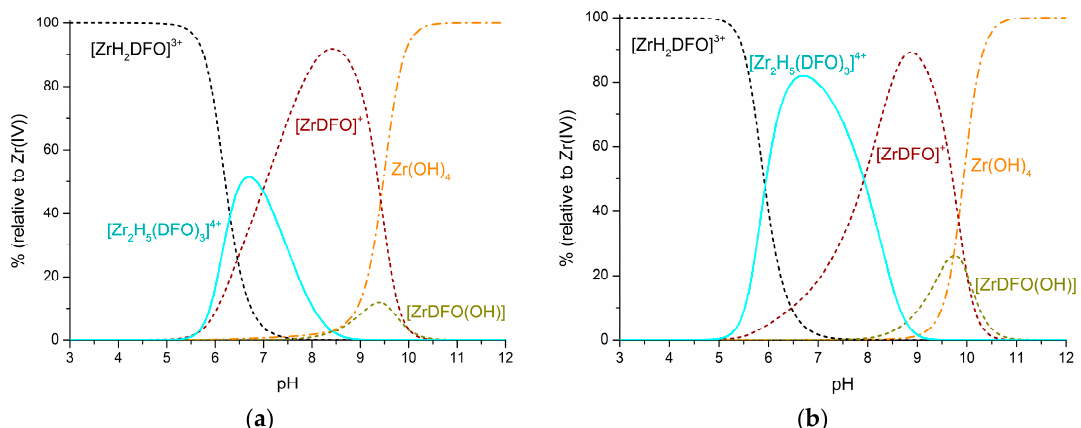
Figure 4. Distribution diagrams of the complexes formed in the Zr 4 + –H 3 DFO system. Solid lines: Binuclear species; dashed lines: Mononuclear species; dash–dot lines: Zr 4 + hydroxo species. ( a ) [Zr 4+ ] = 1 nm, [H 3 DFO] = 10 nM. ( b ) [Zr 4+ ] = 1 nM, [H 3 DFO] = 100 nM. Distribution diagrams were obtained by means of the Hyss program [14] on the basis of the determined equilibrium constants.